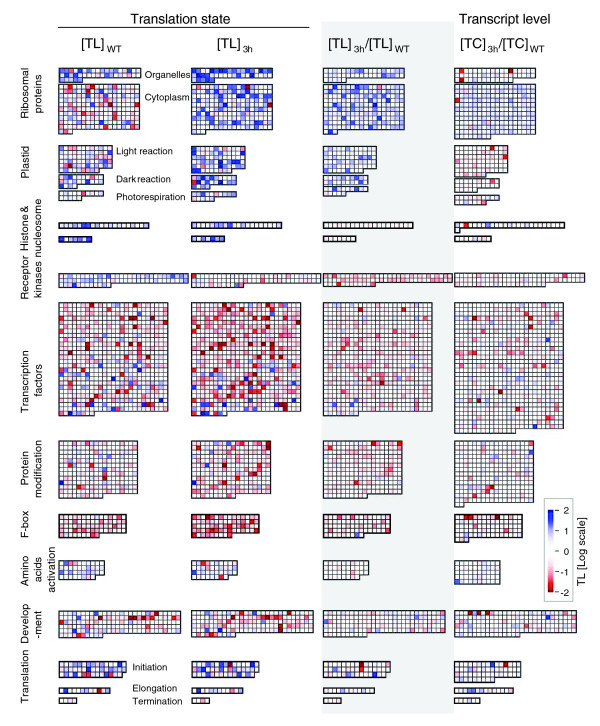
Certain functional classes of mRNAs show a coordinated translational response to the eif3h mutation. Microarray data were plotted onto Arabidopsis biochemical pathways and functional categories using MapMan v1.8.0. Each square represents a single gene. On the log color scale, light blue refers to a 2-fold (log2 = 1) stimulation of polysome loading or transcript level in the eif3h mutant compared to wild type. Note the translational stimulation of ribosomal proteins and plastid proteins in the eif3h mutant and the translational reduction for receptor kinases, transcription factors, F-box proteins, and protein modifying enzymes. Other classes are shown as non-significant controls.